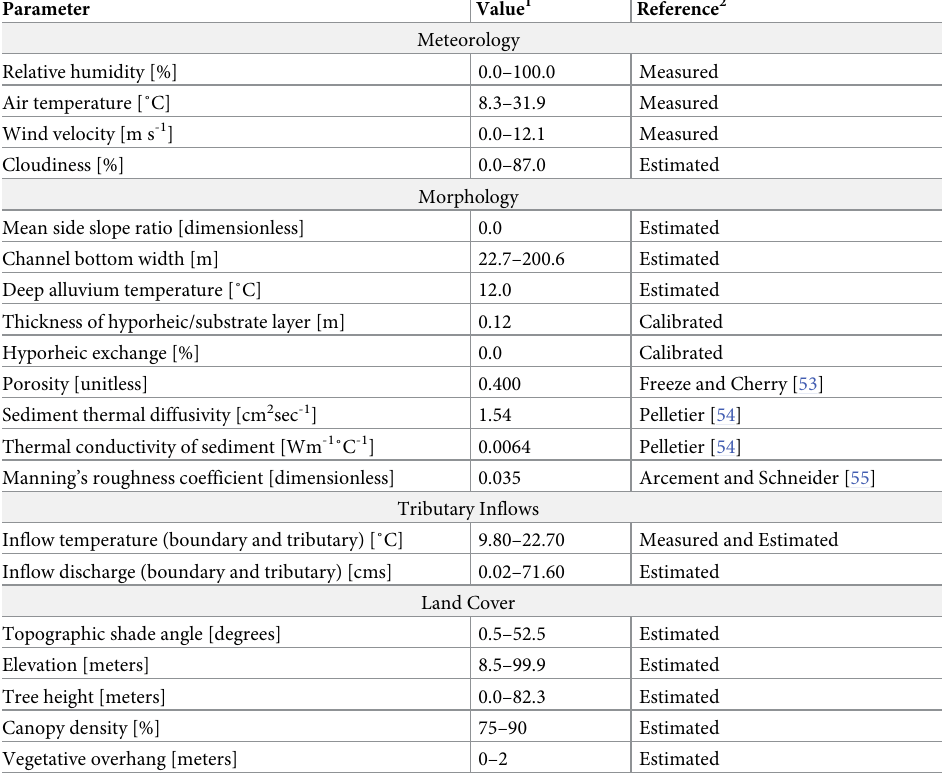
Table 1. Input values used in Heat Source version